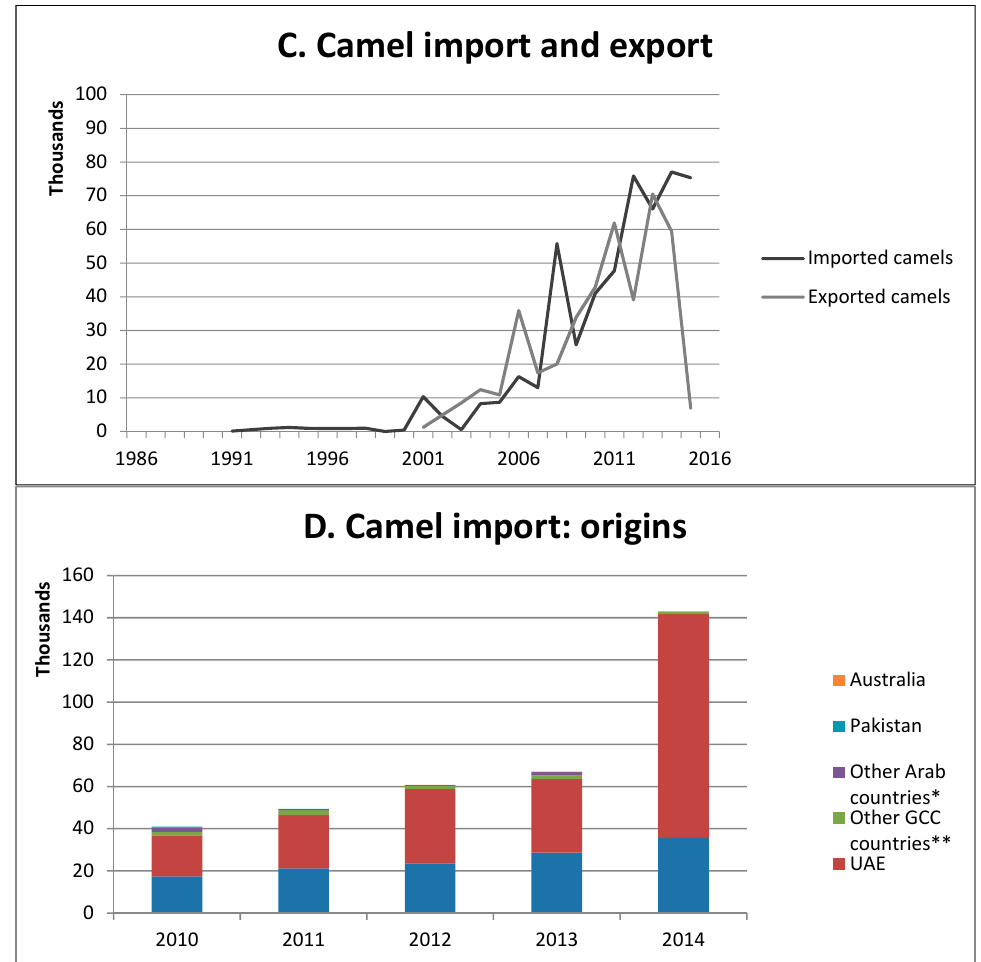
Figure 1. Developments in economy, camel demography, production, and trade. ( A) . Development over time of the gross domestic product per capita; ( B ) Development over time of the camel population; ( C ) Development over time of camel import and export; ( D ) Development over time of camel importation